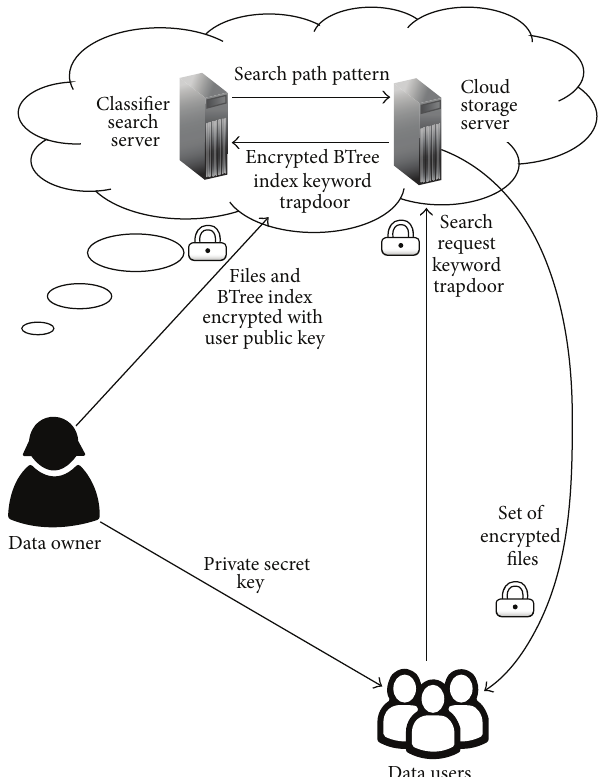
Figure 1: Cloud data utilization service architecture for Asymmetric Classifier Multikeyword Fuzzy